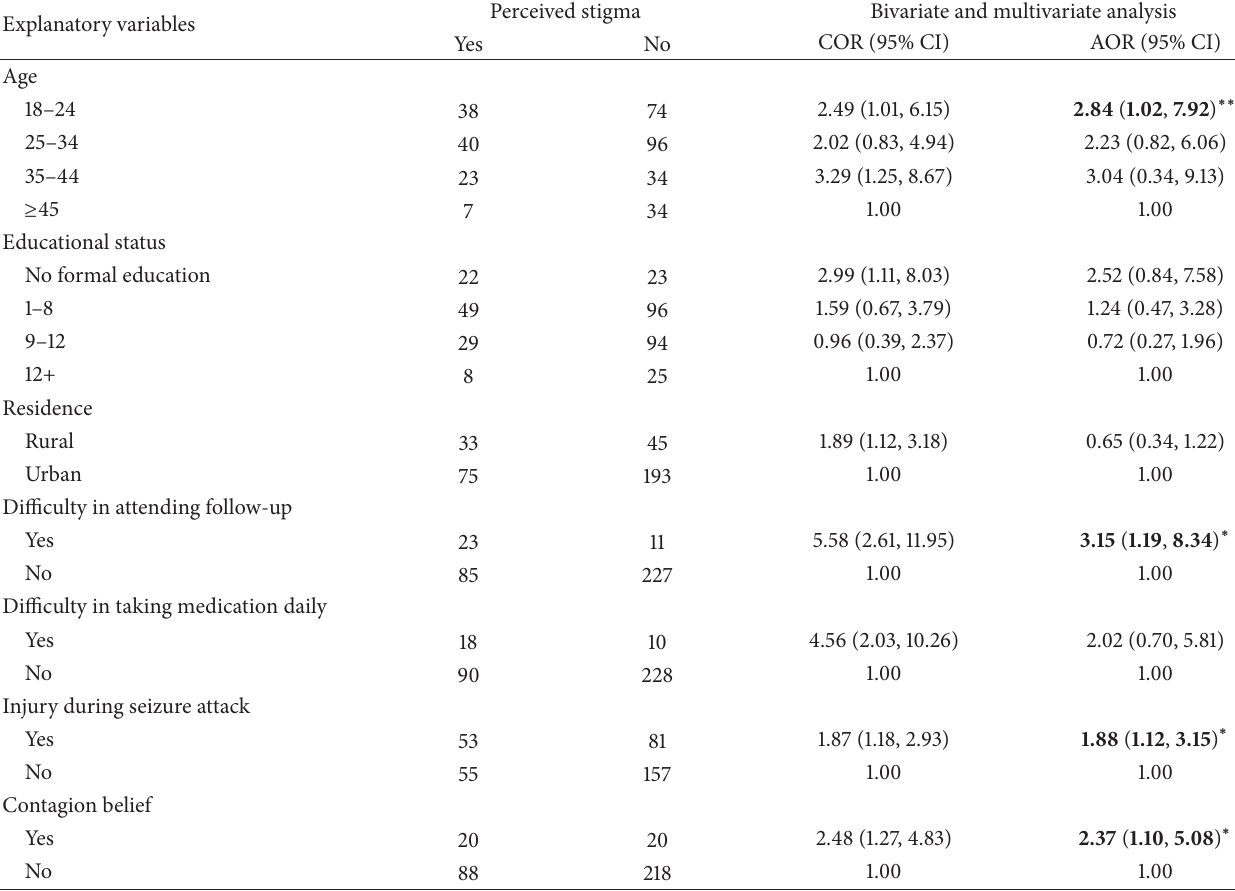
Table 5: Factors associated with perceived stigma of people with epilepsy (bivariate and multivariate analysis). Explanatory